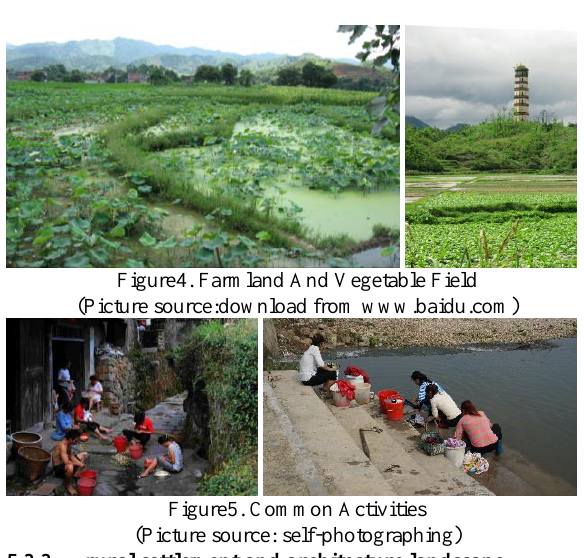
Figure5. Common Activities (Picture source: